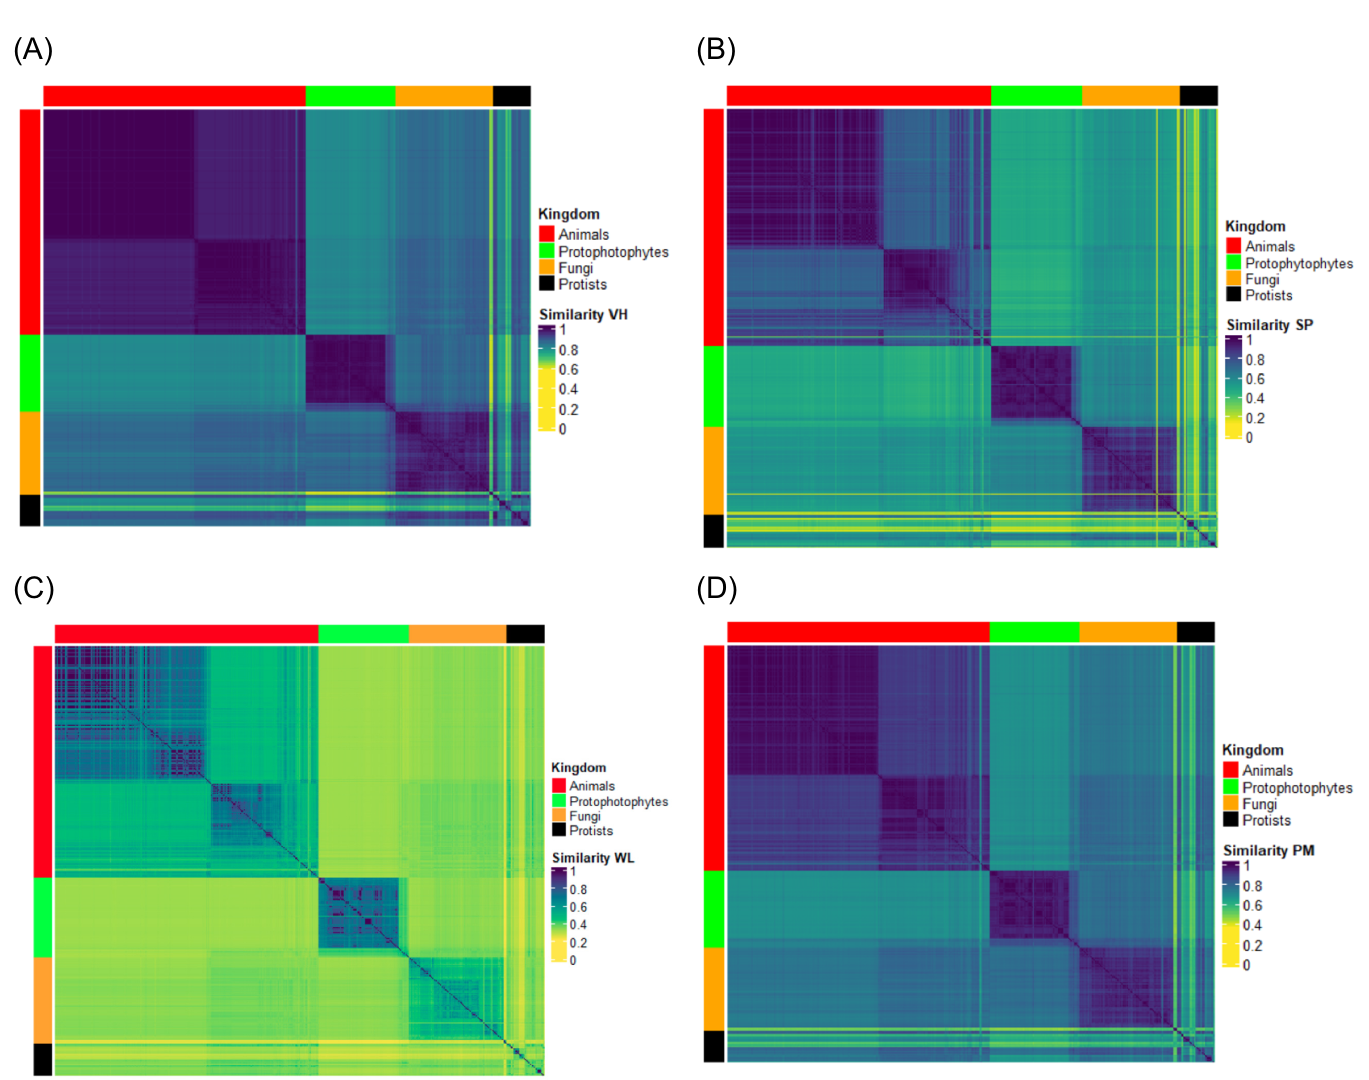
Fig 3. Heatmaps of the similarity matrices of KEGG Eukaryotes at the kingdom level: (a) Vertex Histogram; (b) Shortest Path; (c) Weisfeiler-Lehman; (d) Pyramid Match.